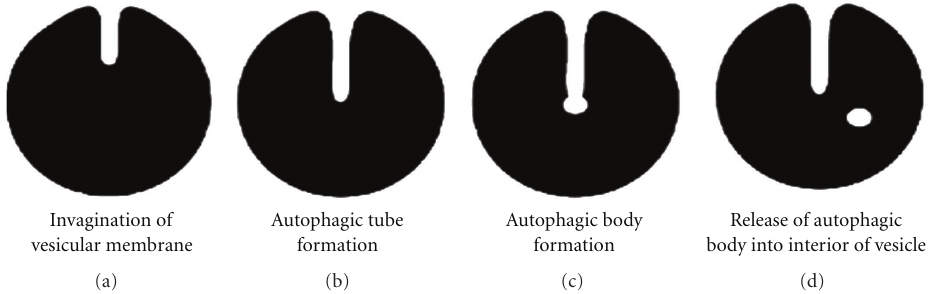
Figure 2: Microautophagy. A direct invagination of a vesicular membrane (lysosome and/or endosome) takes in cytoplasm from the surrounding environment (a). This invagination continues and forms a narrow tube which elongates into the interior of the vacuole (b). This tube is referred to as the autophagic tube and is continuous with the cytoplasm. Entire organelles or compounds within the taken up cytoplasm are degraded within the lumen of the vacuole (if taken in via the lysosome) or fusion with a lysosome occurs, which results in the breakdown of the captured cytosolic components. As the tube reaches the interior of the vacuole, the proximal ends form a bulge referred to as the autophagic body (c). This bulging end is thicker than the tube leading into the vacuole. The walls of the bulging end of the autophagic tube will then fuse, pinching o ff into the inner portions of the lysosome (d). The cytosolic components trapped within the vesicle are then degraded within the vesicle (lysosome or vacuole) or the vesicle (endosome) will later fuse with a lysosome, where the components are then